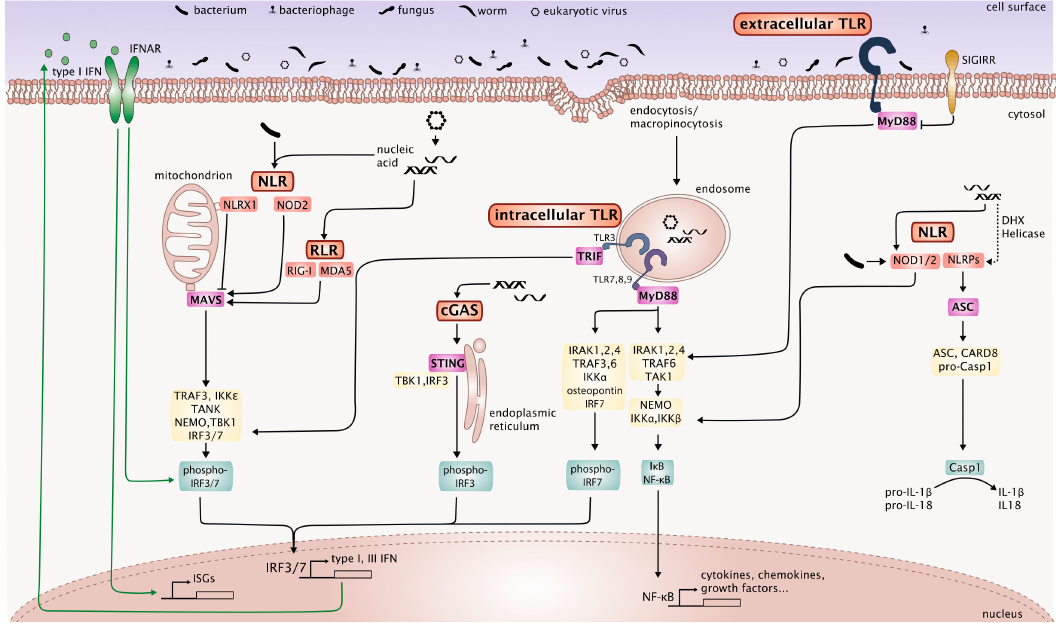
Figure 1. MAMP/PAMP sensing pathways in the intestine. Several PRRs are involved in sensing MAMPs/DAMPs in the intestine: TLRs, RLRs and NLRs. MAMPs/PAMPs are sensed either extracellularly by TLR1/2/4/5/6, or intracellularly by the endosomal TLRs 3/7/8/9 and cytosolic NLRs, RLRs or the cGAS/STING pathway. The receptors (red) signal via adapter proteins (magenta) and further downstream signal components (yellow) to the final players of the respective pathway (green), leading to gene expression or activation of effector molecules. Ligand binding to the extracellular TLRs and the endosomal TLRs 7,8,9 induces signaling via the adapter MyD88, leading to the recruitment and complex formation of IRAK-1/2/4 with TRAF6, TRAF3, IRAK1, IKK α , osteopontin and IRF7. Upon phosphorylation, IRF7 is activated and translocates into the nucleus to induce transcription of type I and III IFN genes. MyD88 signaling can be inhibited by the receptor